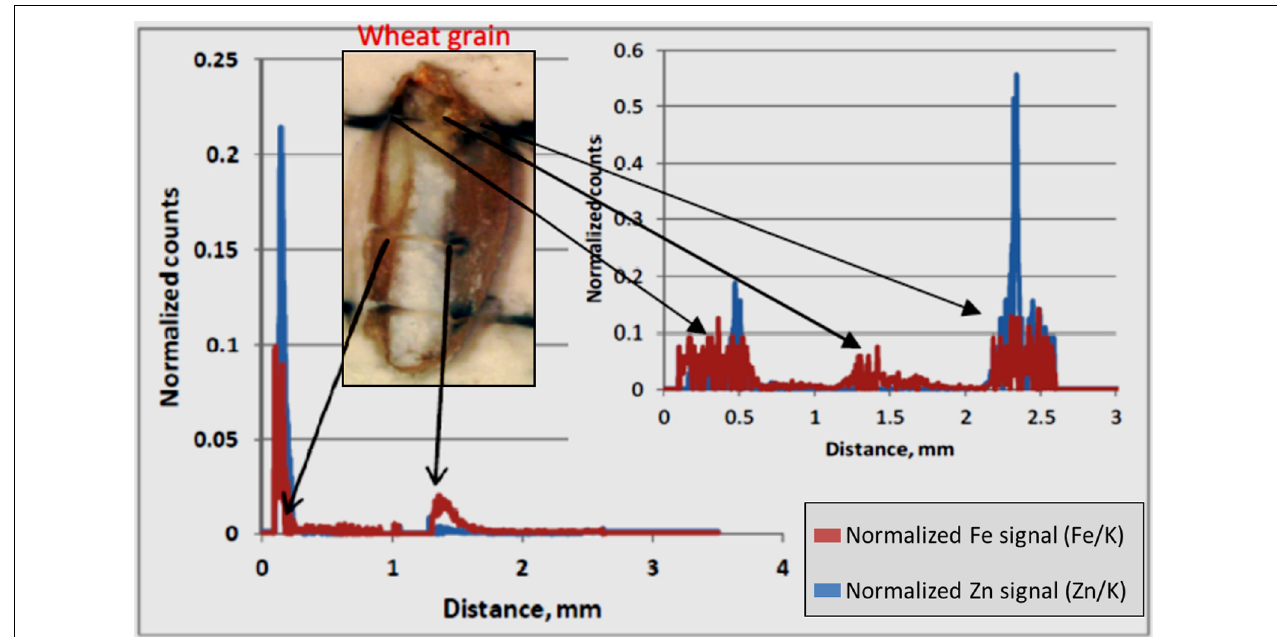
FIGURE 7 | LA-ICP-MS Normalized counts along scan profiles. Normalized counts represent the relative count intensity of Zn and Fe with respect to K. The signals for Zn and Fe for two scan lines are shown. The arrows indicate approximate location for elevated Zn and Fe signals in the grain fall on scan line. The white part in the picture of the wheat grain is the endosperm and bran is on either sides of endosperm. The embryo is at the top the grain. The bran at right hand side of endosperm is the crease.